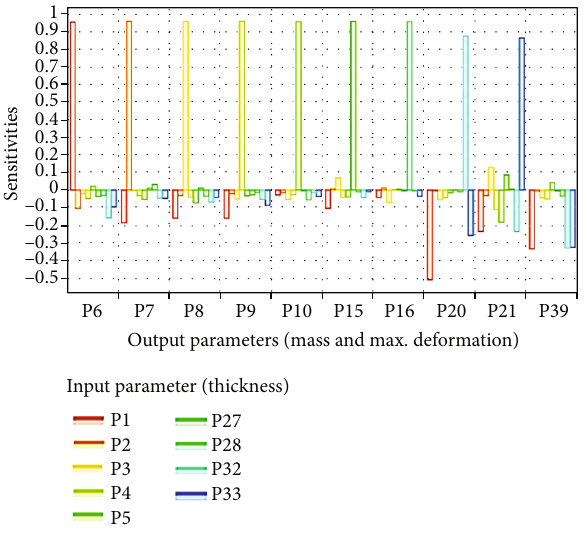
Figure 15: Sensitivities of output